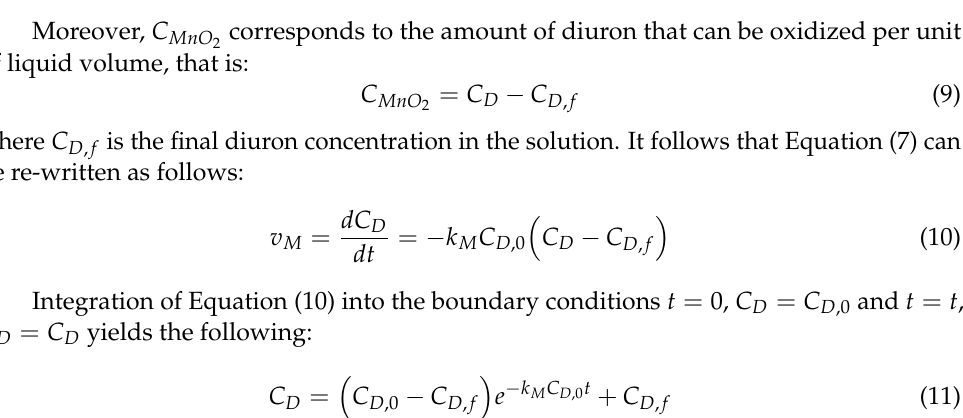
Figure 10. Arrhenius plot for the diuron degradation kinetics in the presence of heat-activated PDS.